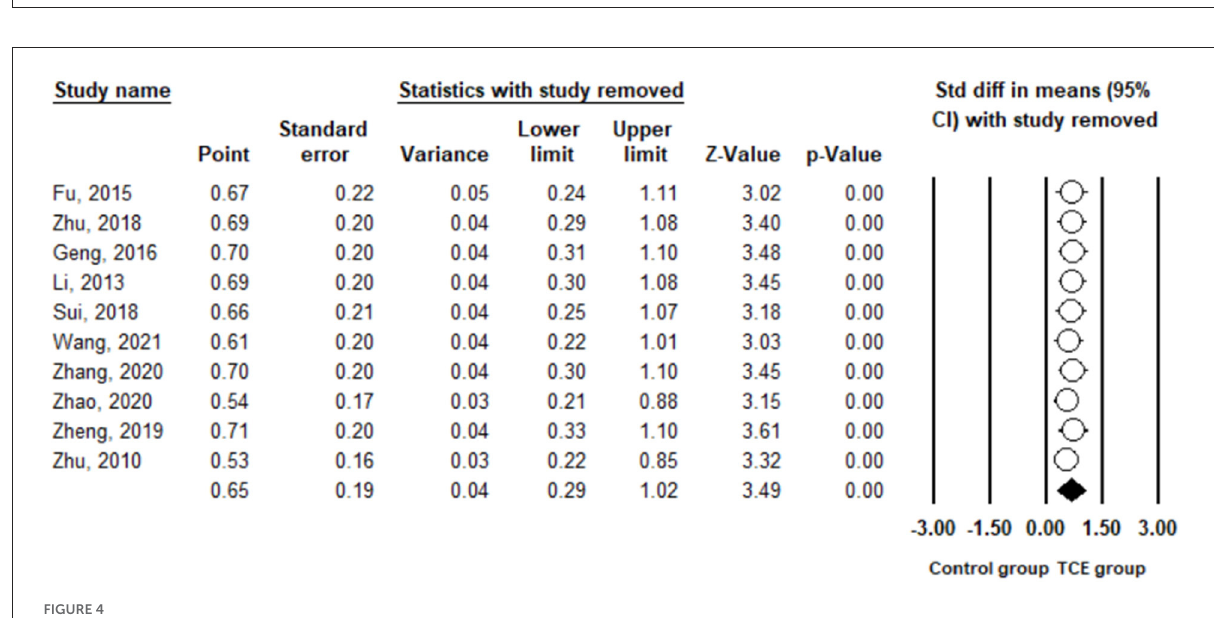
FIGURE4 Leave one out sensitivity analysis for